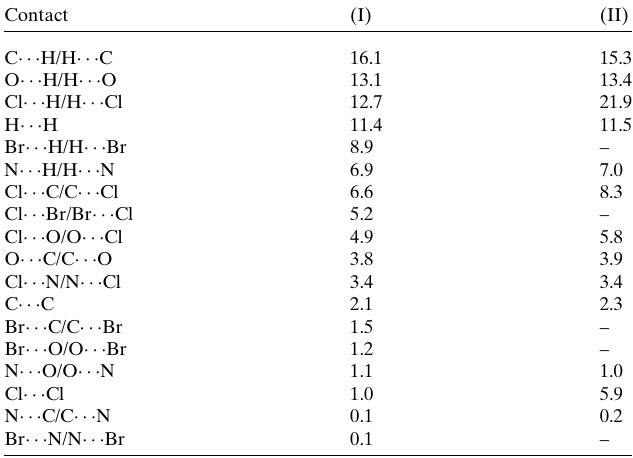
13.1% to the Hirshfeld surface (Fig. 6 b ). The reciprocal Cl (cid:3) (cid:3) (cid:3) H/H (cid:3) (cid:3) (cid:3) Cl interaction with a contribution of 13.8% is present as sharp symmetrical spikes at d For (II), the percentage contributions of various contacts to the total Hirshfeld surface are shown in the two-dimensional fingerprint plots in Fig. 7. The reciprocal Cl (cid:3) (cid:3) (cid:3) H/H (cid:3) (cid:3) (cid:3) Cl interactions appear as two symmetrical broad wings with d ’ 2.9 A˚ and contribute 21.9% to the Hirshfeld surface d i (Fig. 7 b ). The reciprocal C (cid:3) (cid:3) (cid:3) H/H (cid:3) (cid:3) (cid:3) C and O (cid:3) (cid:3) (cid:3) H/H (cid:3) (cid:3) (cid:3) O interactions (15.3, 13.4% contributions, respectively) are present as sharp symmetrical spikes at d 2.5 A˚ , respectively (Fig. 7 c – d ). The small percentage contri-